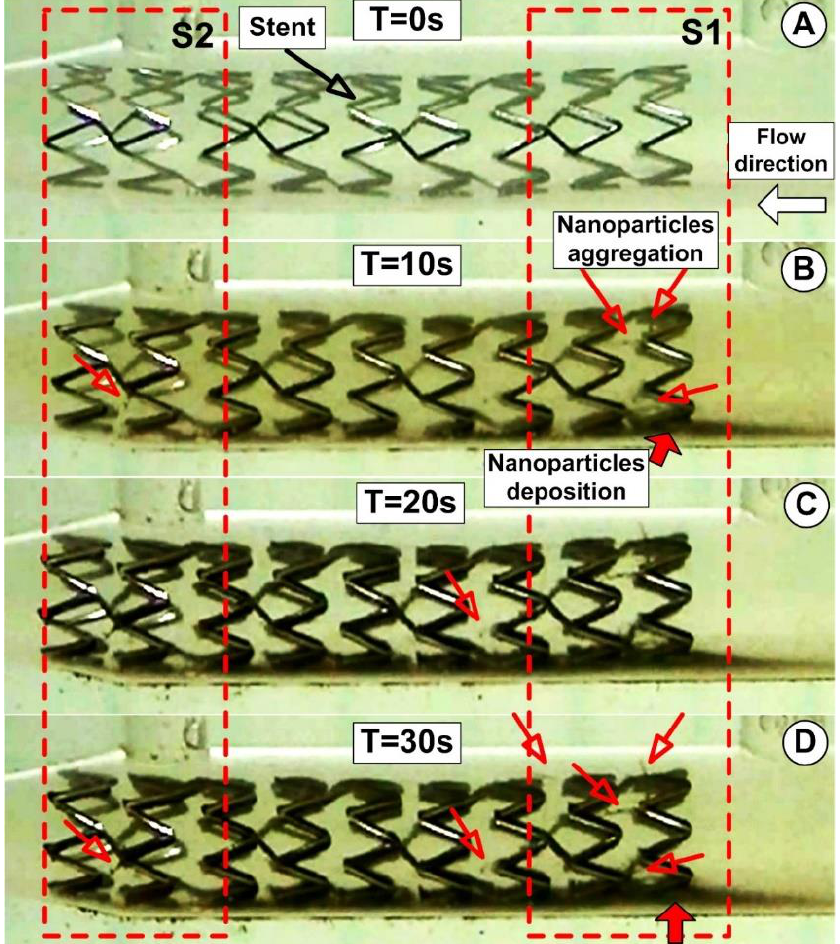
Figure 10. Magnetically induced large scales aggregation of the PEG_MNC around the targeted magnetic stent. Aggregation size evolution during different time steps of the injection period of 30 s. S1 and S2 regions where chain-like magnetic particles structure are generated (red arrows).